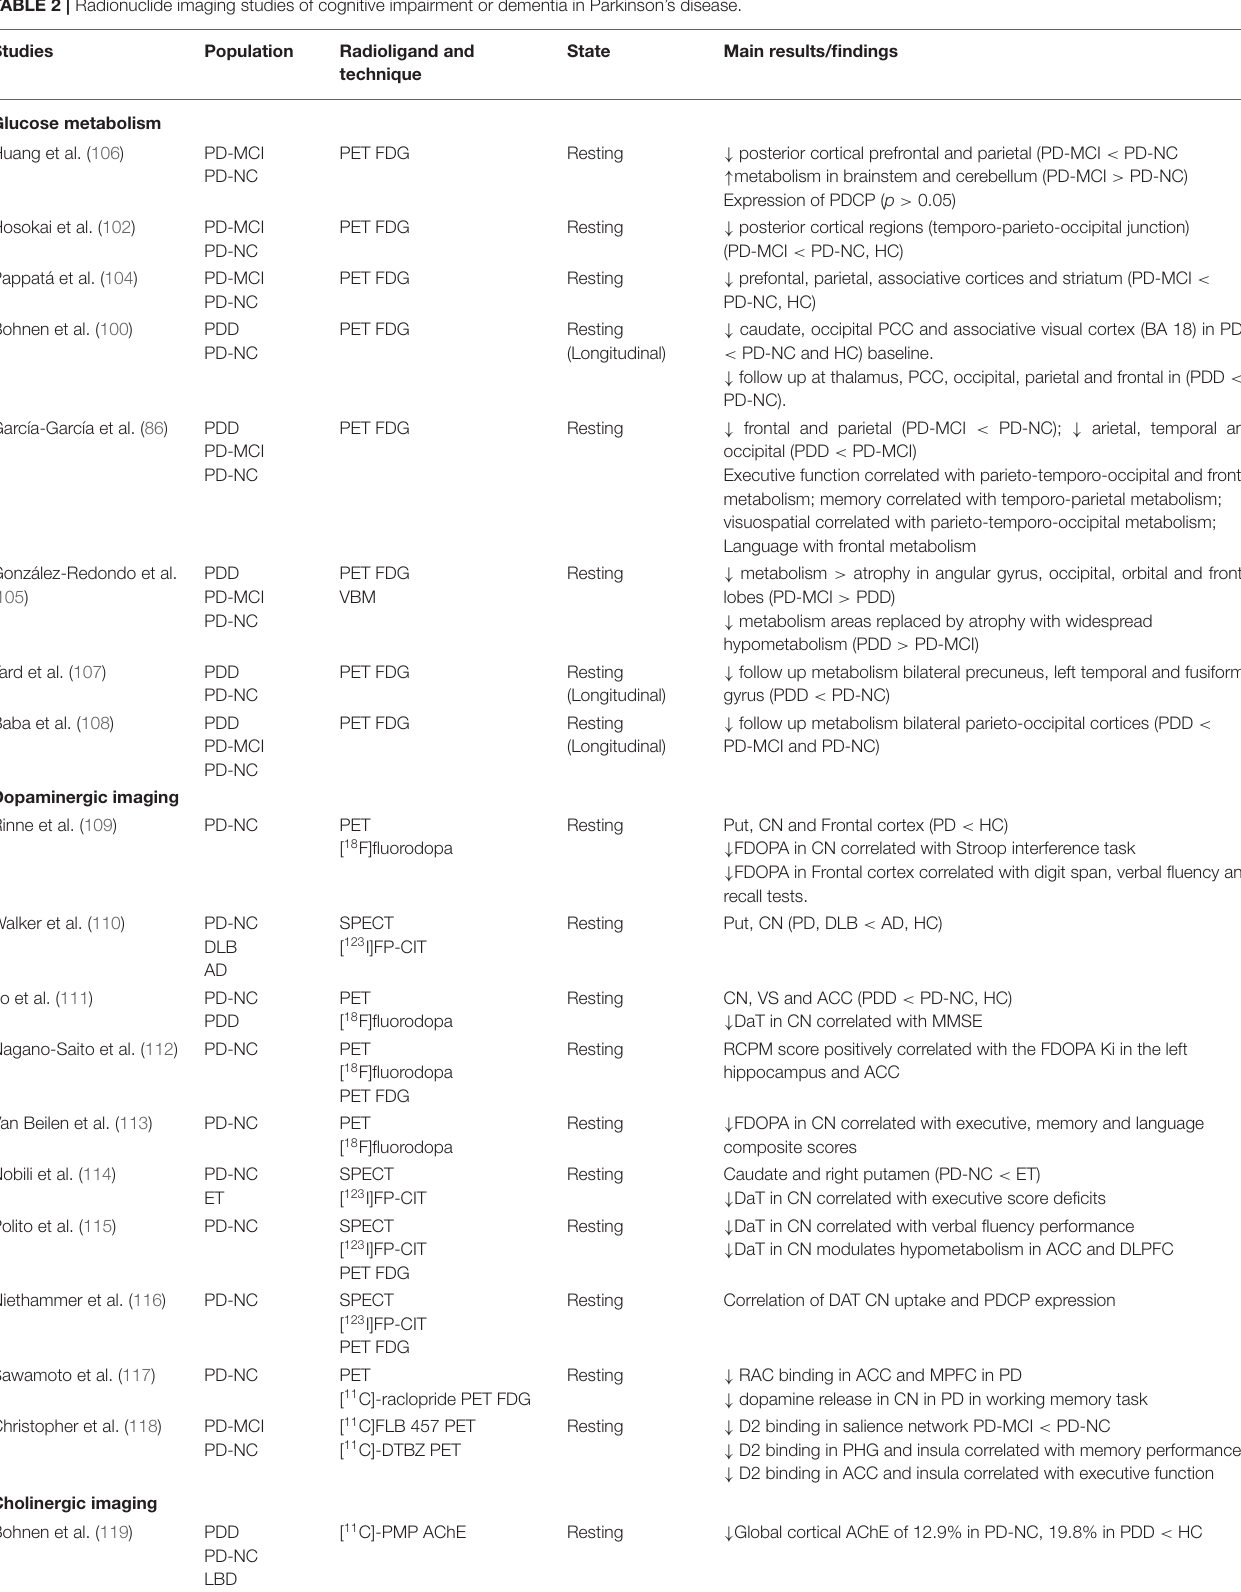
TABLE 2 | Radionuclide imaging studies of cognitive impairment or dementia in Parkinson’s disease.